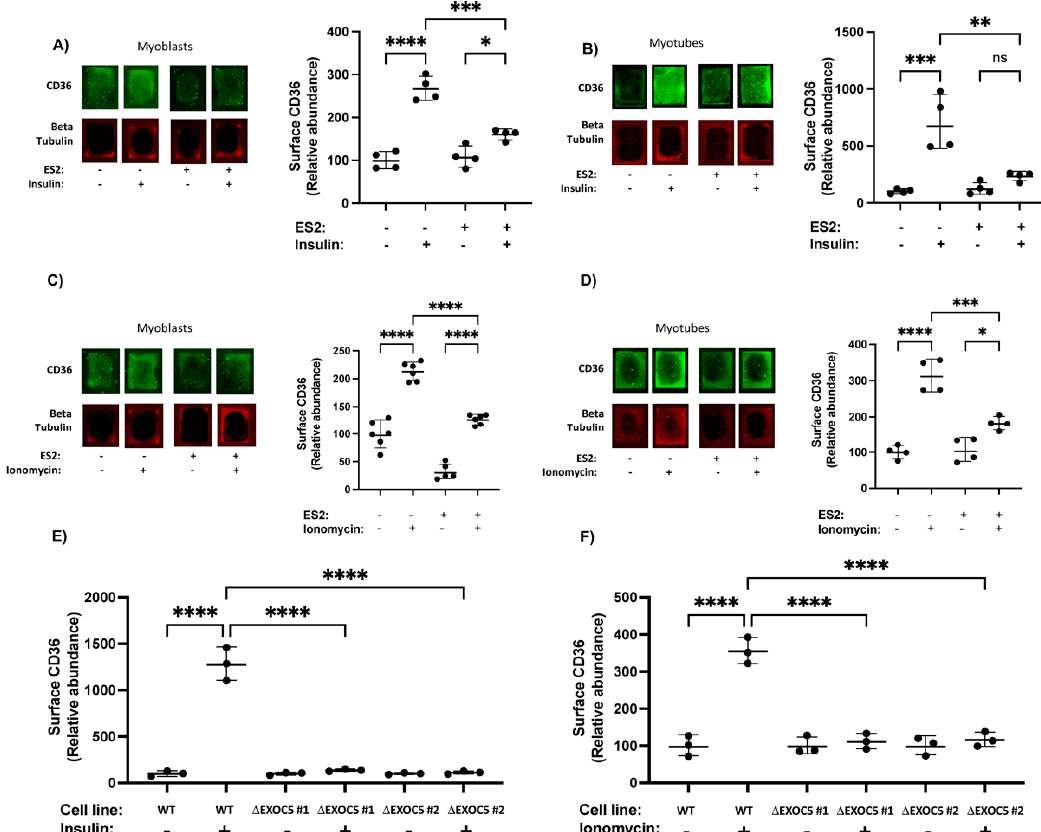
Figure 2. Disrupted exocyst function impairs CD36 membrane delivery. Representative in − cell Western analysis shows that insulin stimulates higher cell − surface levels of CD36 in L6 GLUT4myc myoblasts ( A ) and differentiated myotubes ( B ), an effect significantly reduced in the presence of the exocyst inhibitor ES2. Signal intensities of the entire surface of the chamber slide wells were measured with a fluorescent scanner. Surface CD36 levels were normalized to β − tubulin levels measured following permeabilization and immunostaining. Representative in − cell Western analysis and quantitation reveal elevated cell surface CD36 levels in L6 GLUT4myc myoblasts ( C ) and differentiated myotubes ( D ) treated with ionomycin. This response to ionomycin treatment is blunted in the presence of ES2. Quantification of relative surface CD36 levels in wild − type and Δ EXOC5 myoblasts treated with insulin ( E ) or ionomycin ( F ) indicates that exocyst disruption impairs membrane trafficking of the FFA translocase. Data are means ±S.D. in percent ratios rela- tive to the untreated or wild − type controls. * p < 0.05; ** p < 0.01; *** p < 0.005; **** p < 0.0005; ns: p > 0.05. The images and data presented are representative of three independent measurements.